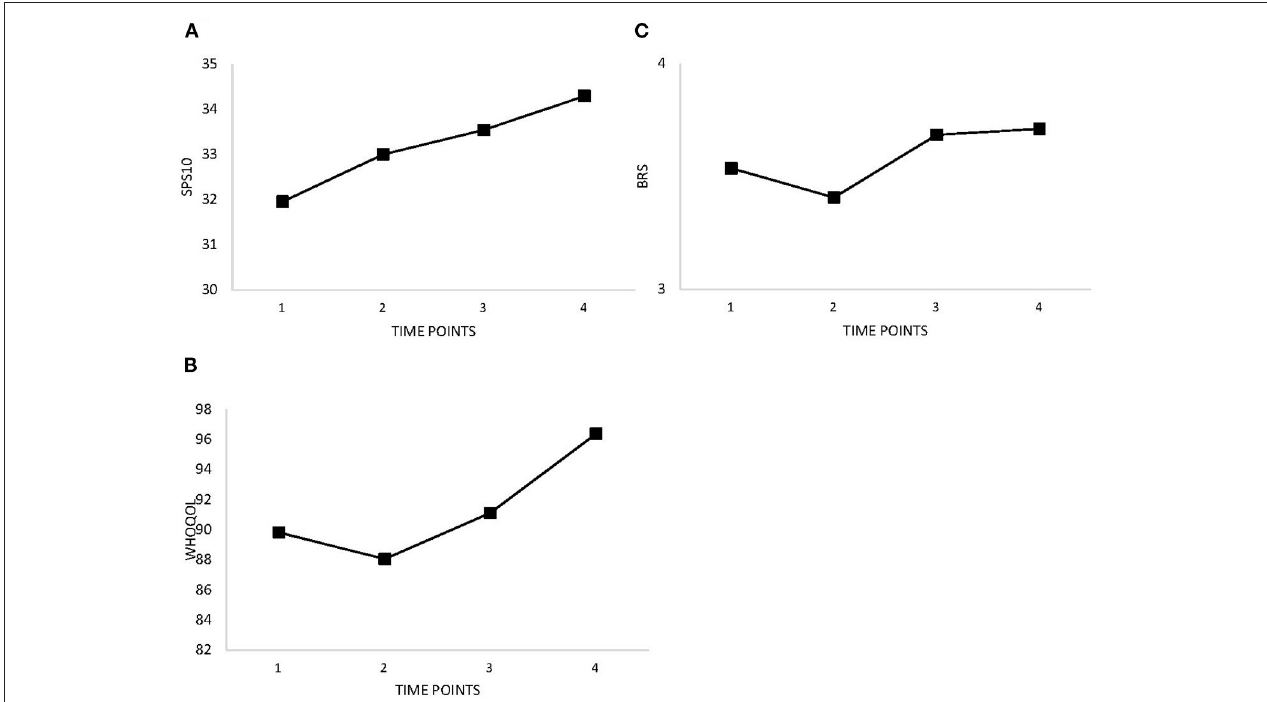
FIGURE 3 | Changes in social support, resilience, and quality of life as measured at baseline (Time 1), 8 weeks (Time 2), 3 months (Time 3), and 6 months (Time 4). (A) Social Support (SPS-10). (B) Quality of Life (WHOQOL). (C) Resilience